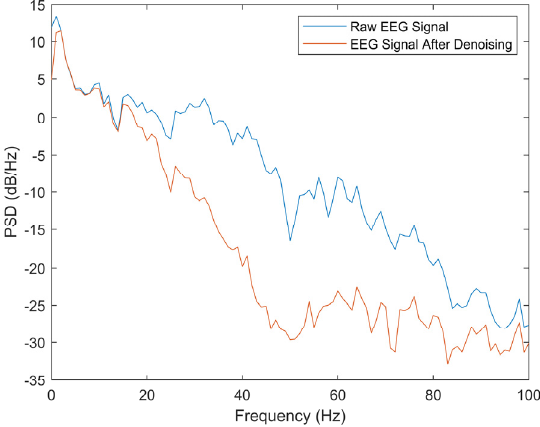
Figure 7. PSD of EEG Before and After Denoising.